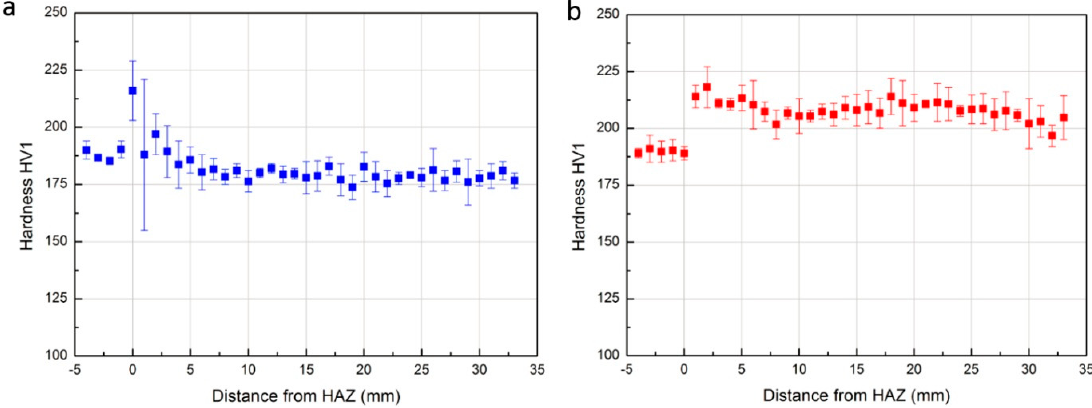
Figure 7. Microhardness profile in the cross-section as the function of the distance from HAZ. ( a ) Before PWHT; ( b ) After PWHT.